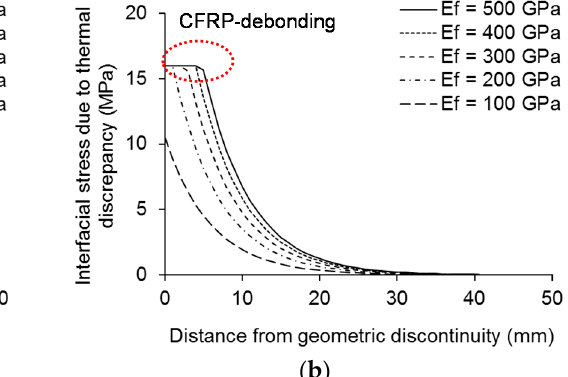
Figure 13. Effect of CFRP modulus: ( a ) at Δ T = 20 °C; ( b ) at Δ T = 60 °C.